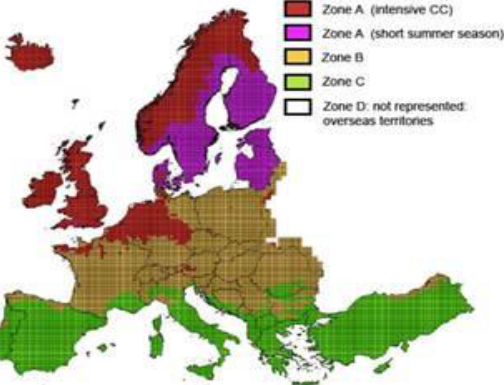
Figure 1. Zone map of maximum accepted cloud / haze coverage in Europe (from DWH, 2014).